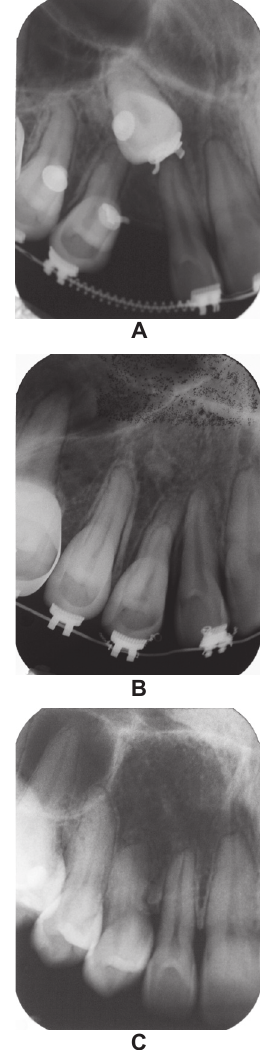
Figure 4- Periapical radiographic sequence.